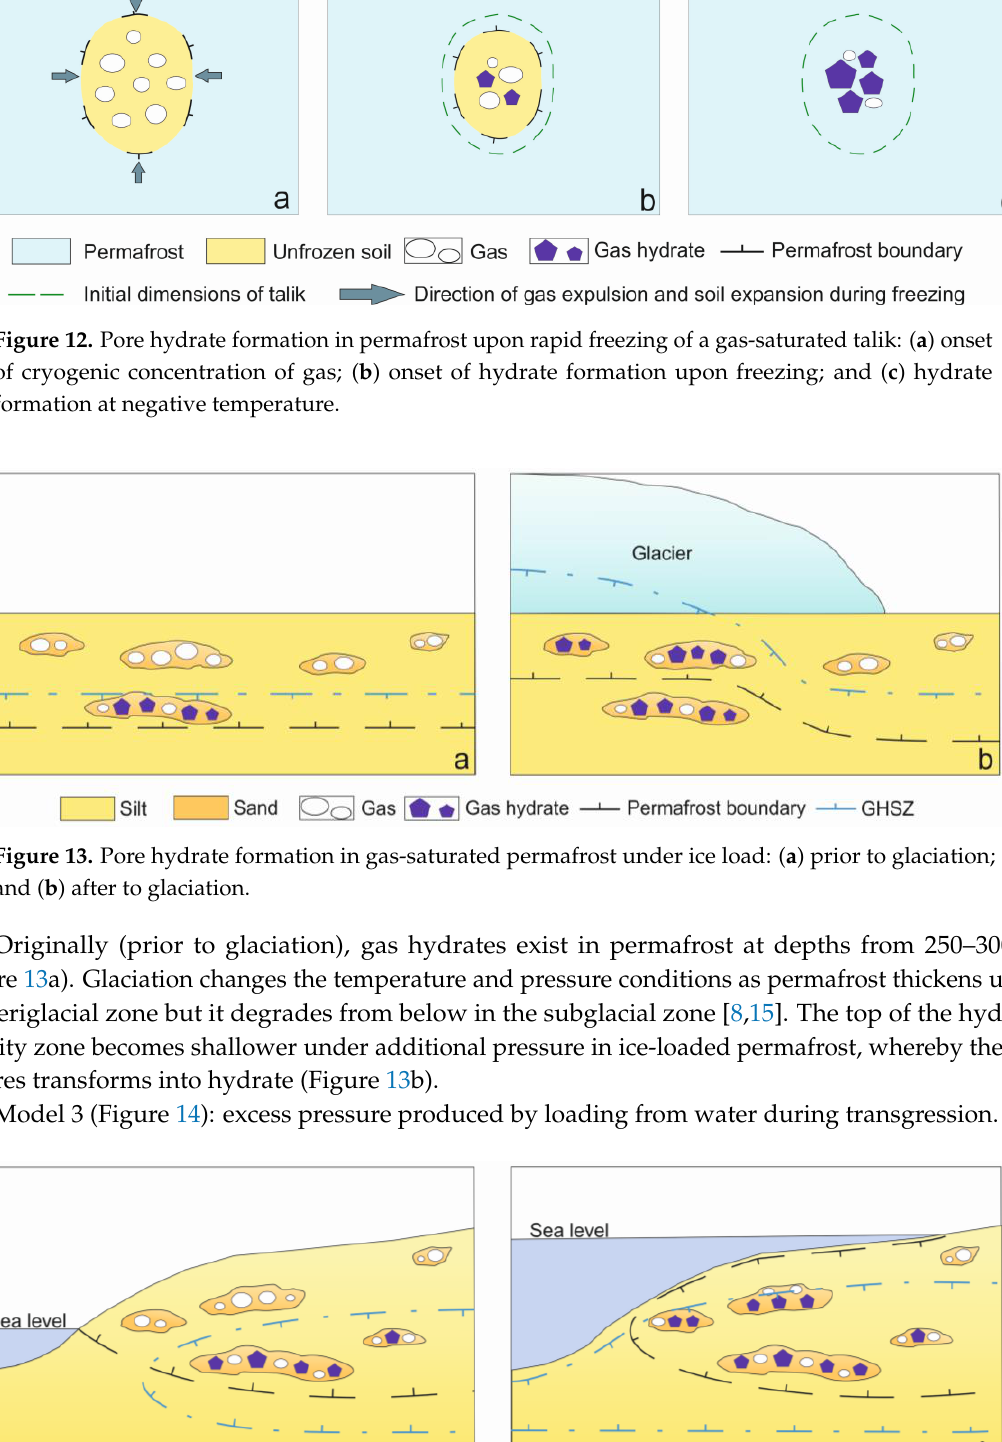
Figure 14. Pore hydrate formation in gas-saturated permafrost under water load: ( a ) prior to transgression and ( b ) after to transgression.